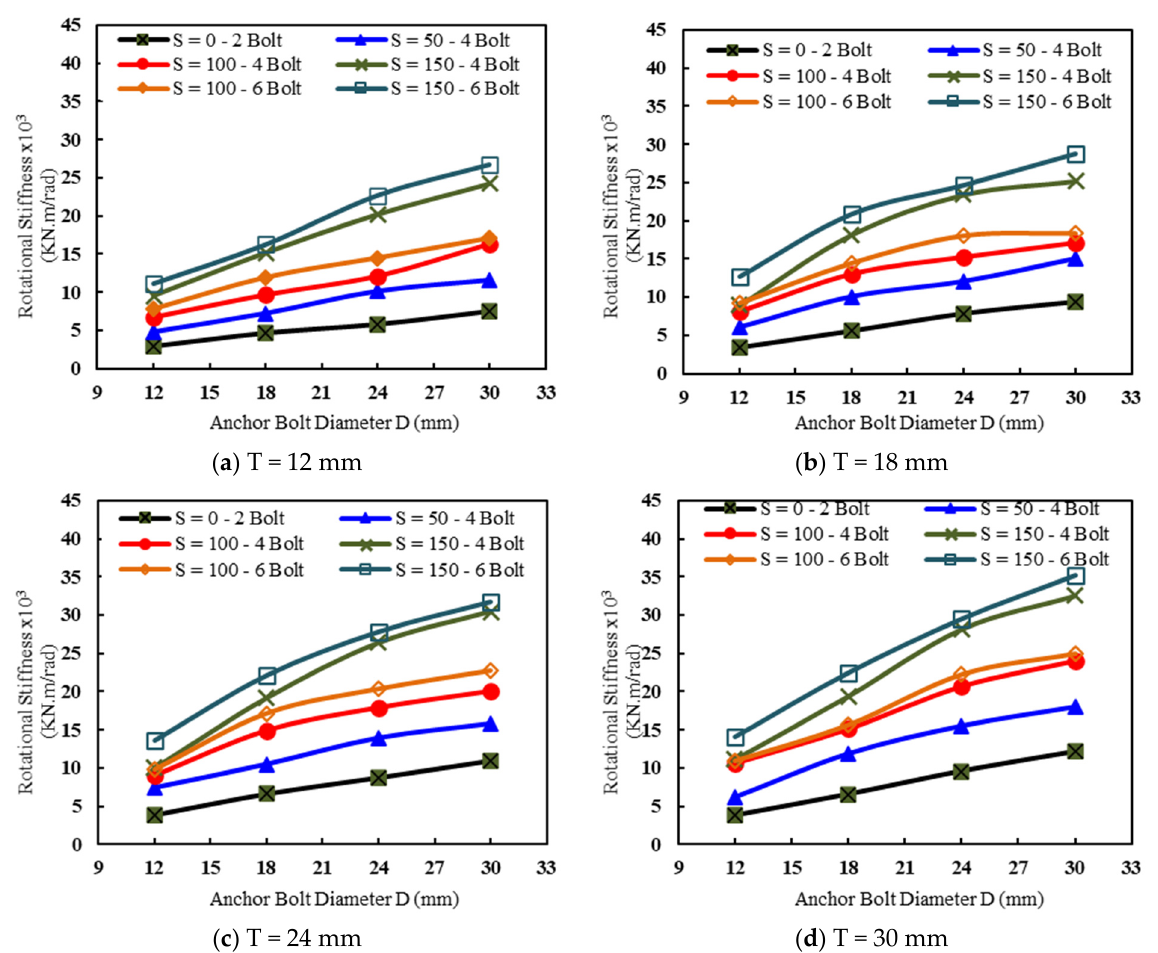
Figure 22. The rotational stiffness vs. the anchor bolt diameter for different anchor bolt arrangement and plate thicknesses: ( a ) T = 12 mm, ( b ) T = 18 mm, ( c ) T = 24 mm, and ( d ) T = 30 mm.